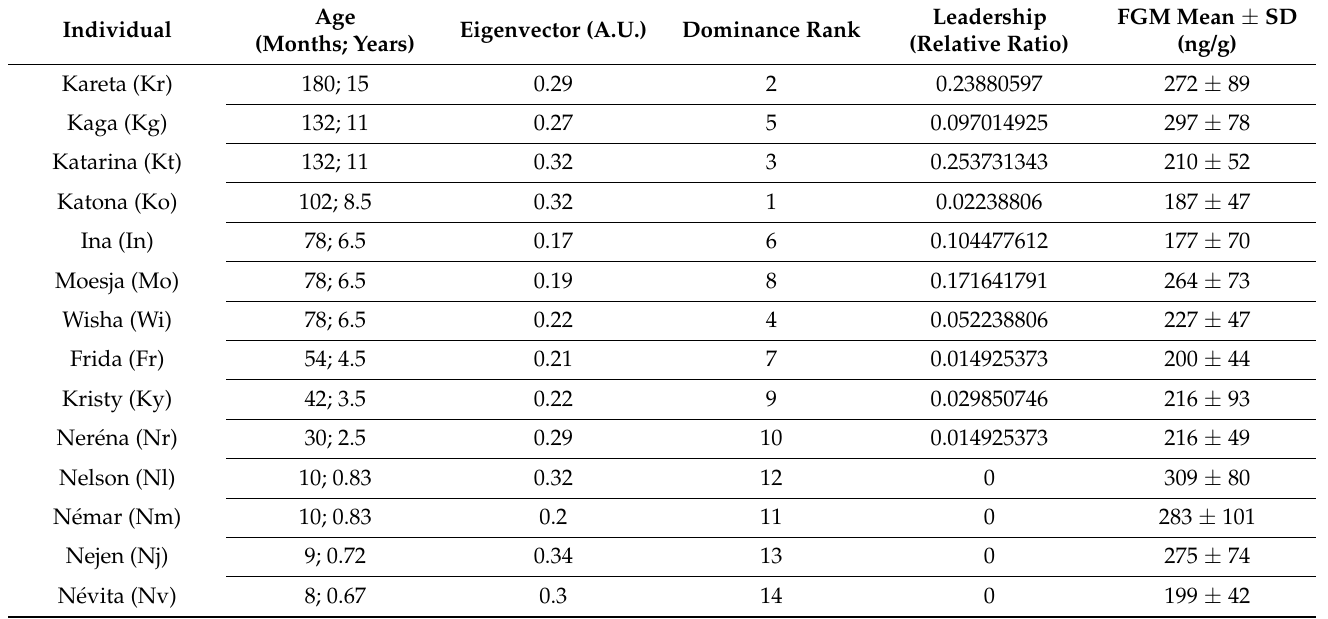
Table 1. Individual measures for the total observation period. Higher rank individual is ranked 1 whilst lower rank individual is ranked 14. A.U. means arbitrary